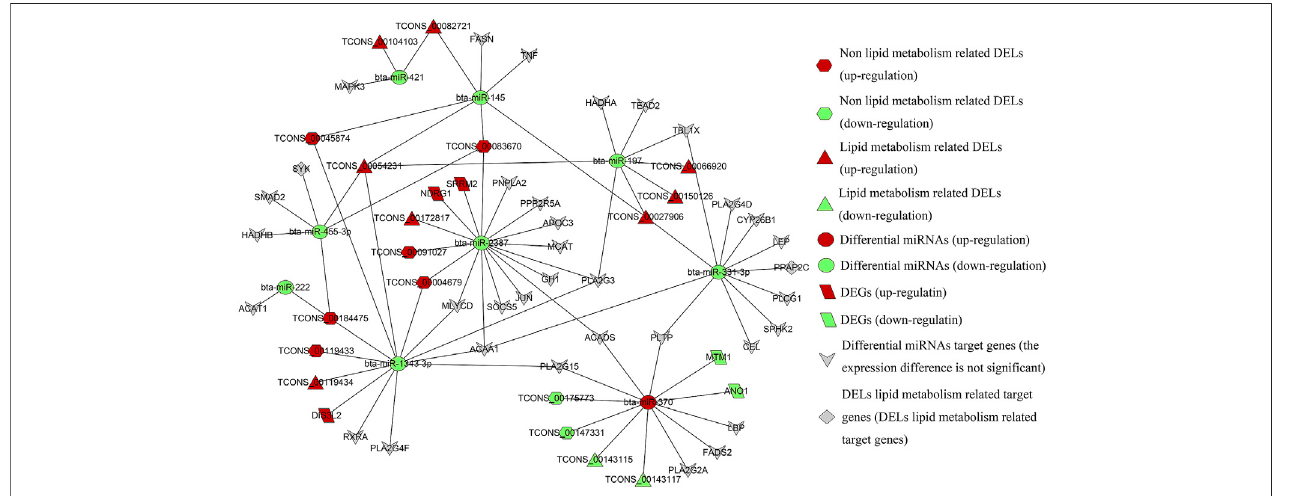
FIGURE 9 | Regulatory network of DELs differential miRNAs_ target